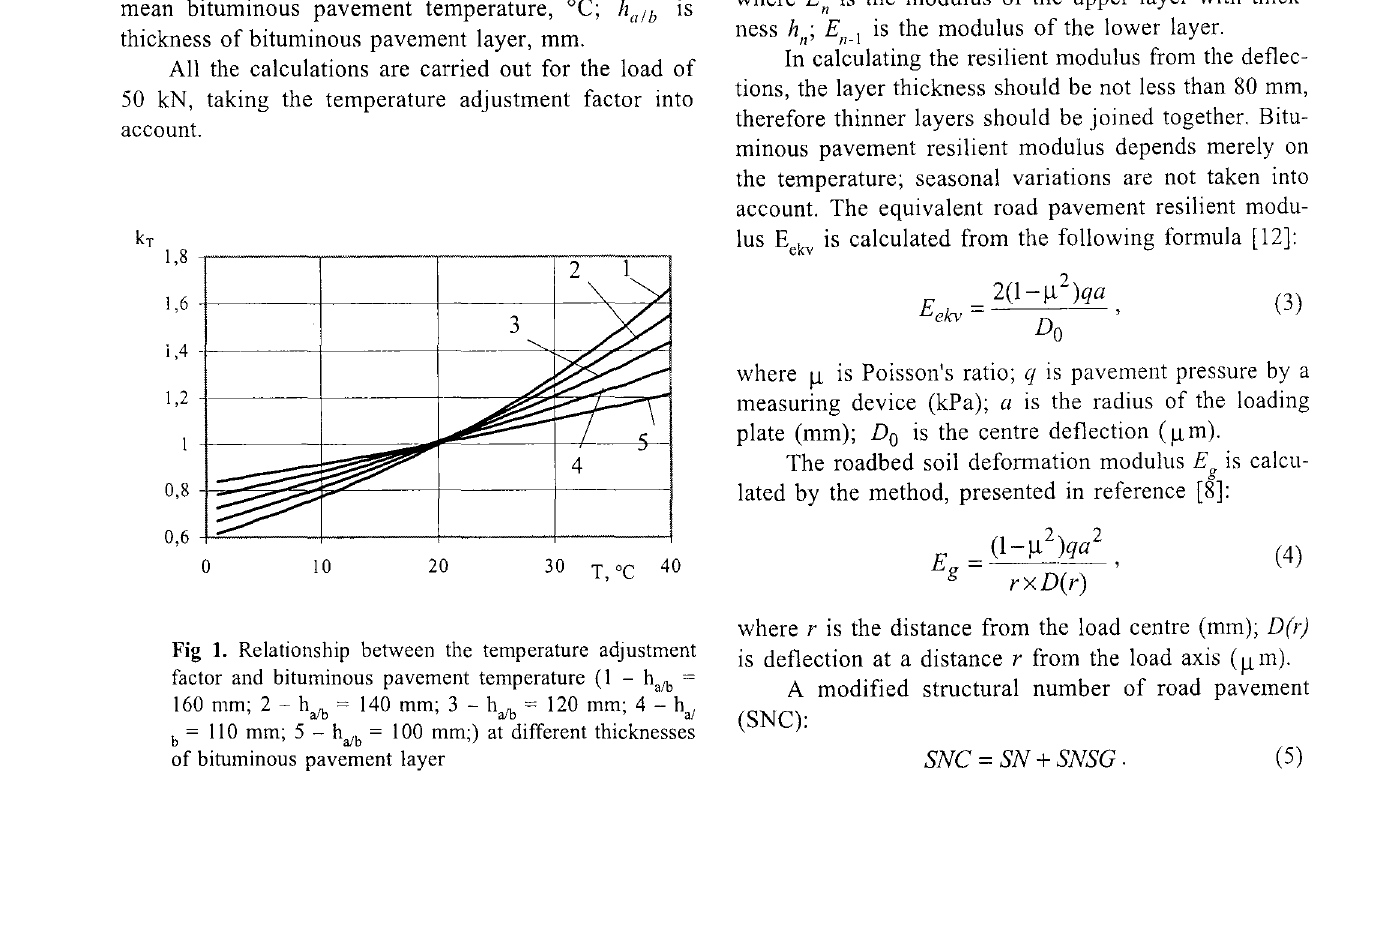
Fig 1. Relationship between the temperature adjustment factor and bituminous pavement temperature (I - ha/b = 160 mm; 2 - ha/b = 140 mm; 3 - ha/b = 120 mm; 4 - h b = II 0 mm; 5 - haJb = I 00 mm;) at different thicknesses of bituminous pavement